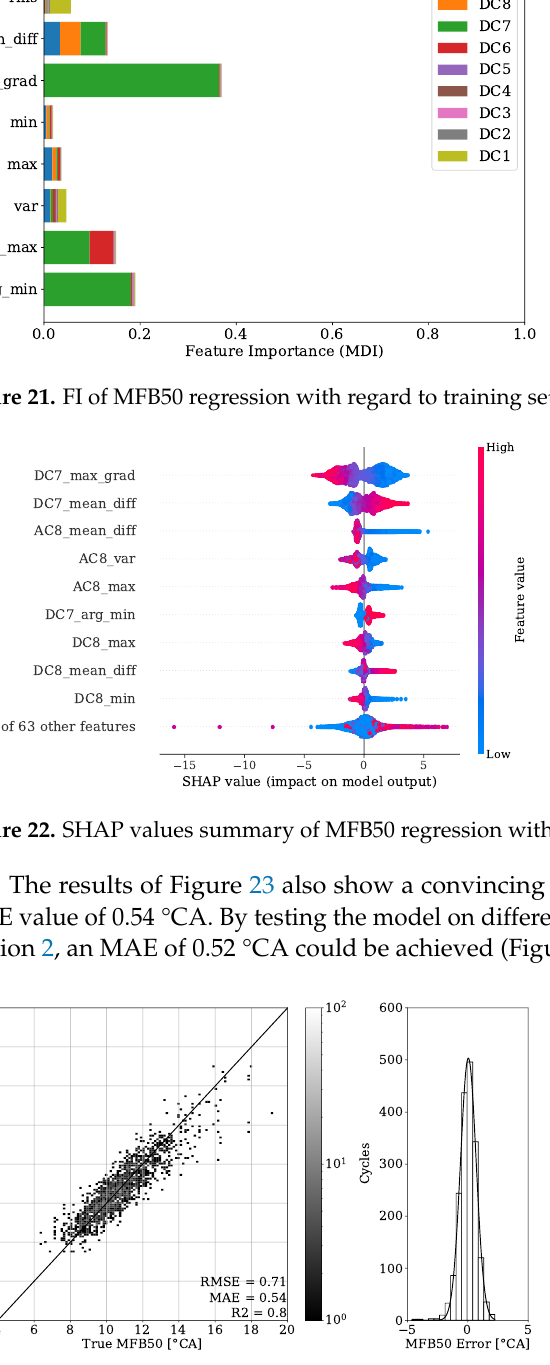
Figure 23. MFB50 regression of validation set from engine